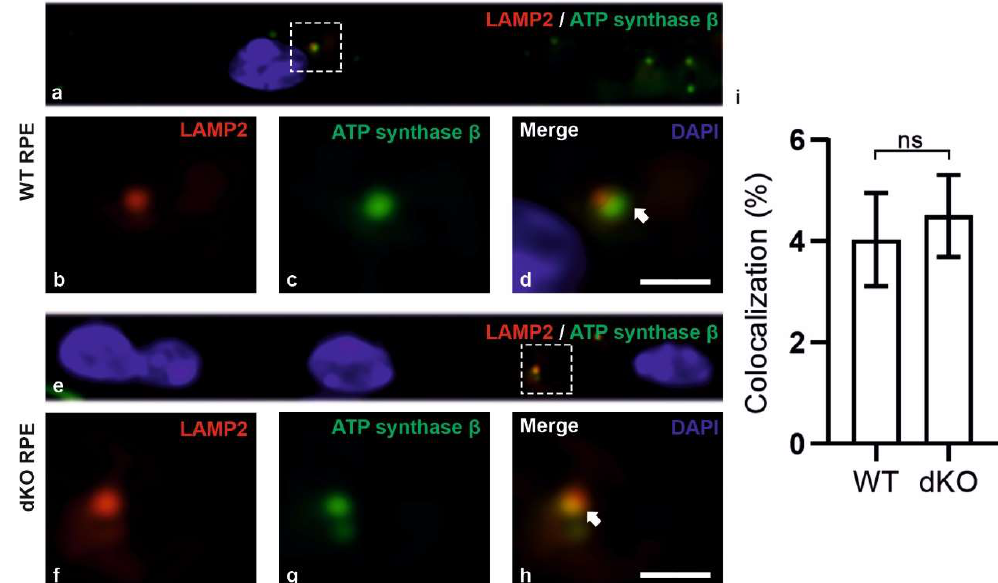
Figure 6. Confocal microscopy analysis of lysosomal marker LAMP2 and mitochondrial marker ATP synthase β in WT and dKO RPE cells ( a , e ). The colocalization of LAMP2 ( b , f ) and ATP synthase β ( c , g ) shows the amount of autolysosome formation. Image analysis showed no significant changes in LAMP2 and ATP synthase β colocalization in dKO animals compared to WT ( d , h and i ). Scale = 5 µm. p = 0.70. ns—Nonsignificant.